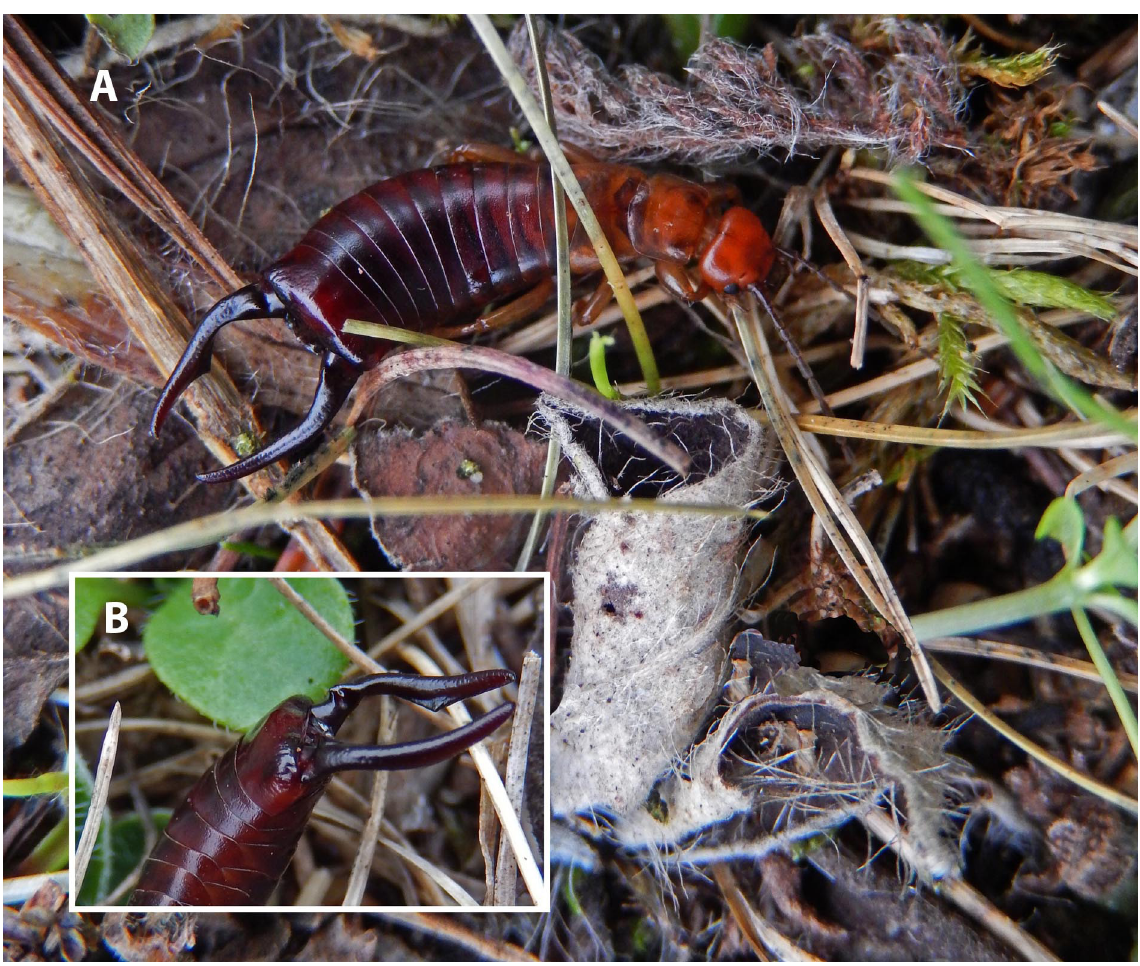
Fig. 7. Pseudochelidura cantabrica Cuesta-Segura, Jurado-Angulo & García-París sp. nov., holotype, ♂ (MNCN_Ent 167418). A . Photographed alive at Puerto de la Farrapona (León, Spain) . B . Lateral view of the cerci. Photographs in situ by